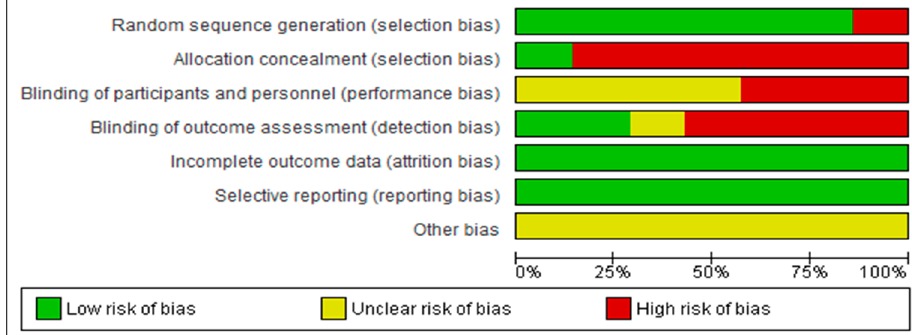
Figure 3. Overall risk of bias. Each category is presented by percentages.